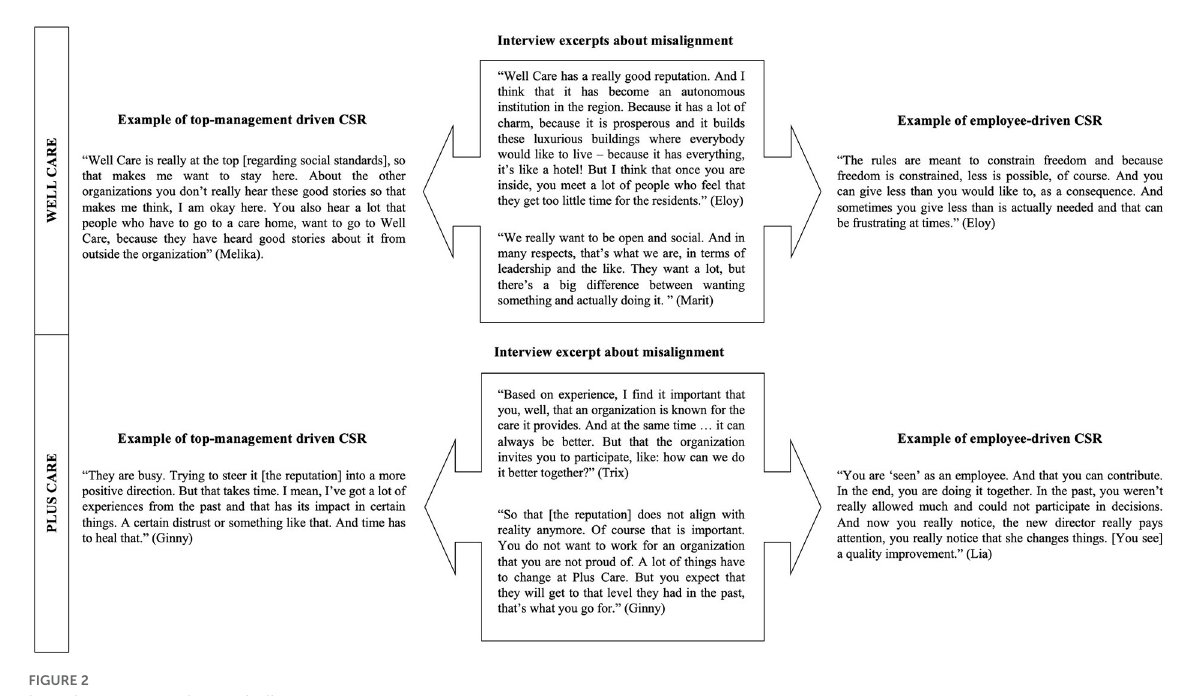
FIGURE2 Interview excerpts about